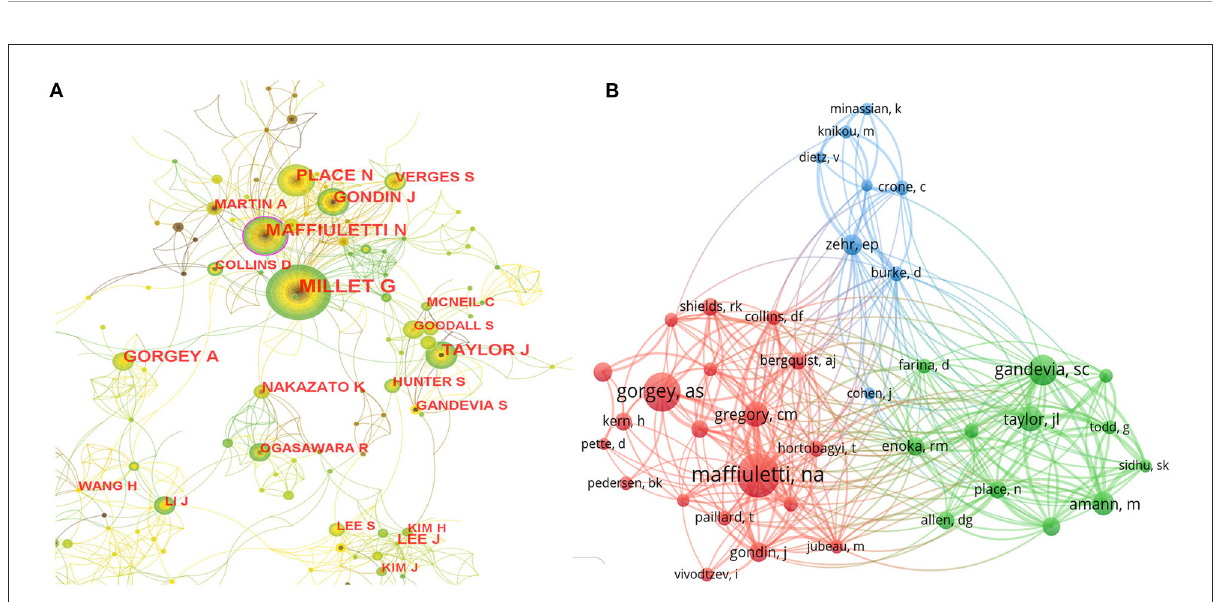
FIGURE4 Collaboration network map of (A) authors and (B) co-cited